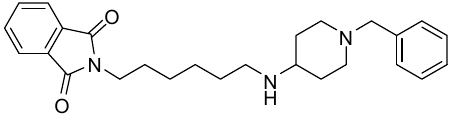
values [32]. 50 N HNO N O 1 . AChE: IC 50 = 18.2  M; BuChE: IC 50 = 22.8  M HNO N N O 2 . AChE: IC 50 = 53.7  M; BuChE: IC 50 = 24.5 